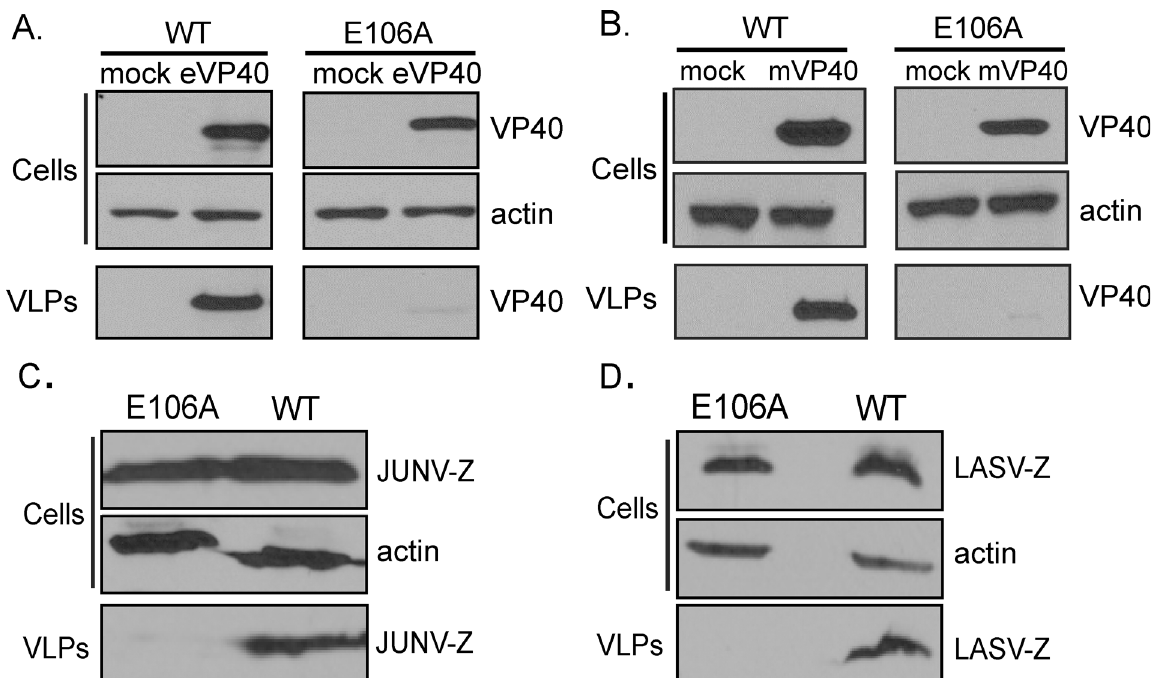
Fig 2. Budding of filovirus and arenavirus VLPs from WT and E106A cells. WT or Orai1 E106A mutant HEK293T cells were transfected as indicated with eVP40 (A) , mVP40 (B) , JUNV-Z (C) , or LASV-Z (D) for 24 hours and VP40 or Z protein levels in cells and VLPs were quantified by immunoblot analysis. Expression of cellular actin served as a loading control. Results are representative of three independent